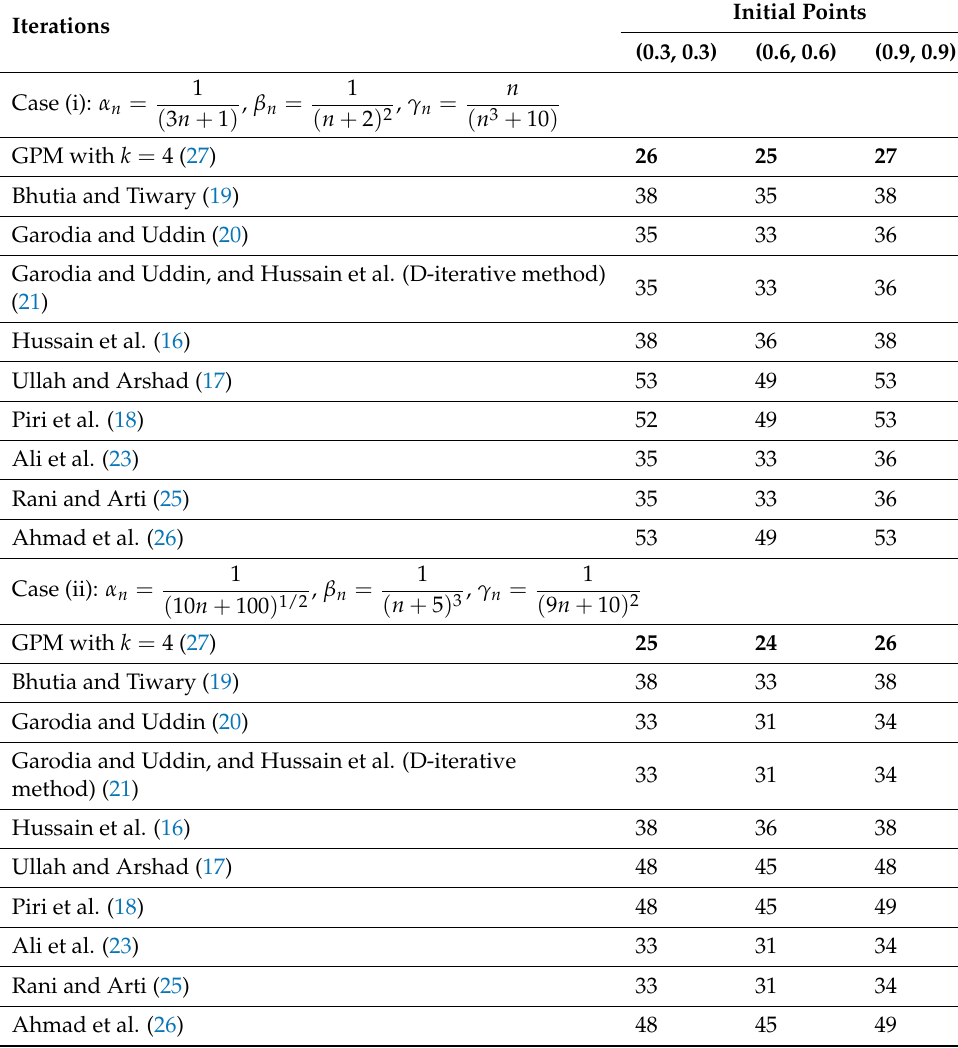
Table 1. Influence of initial guesses and parameters: comparison of various iterative